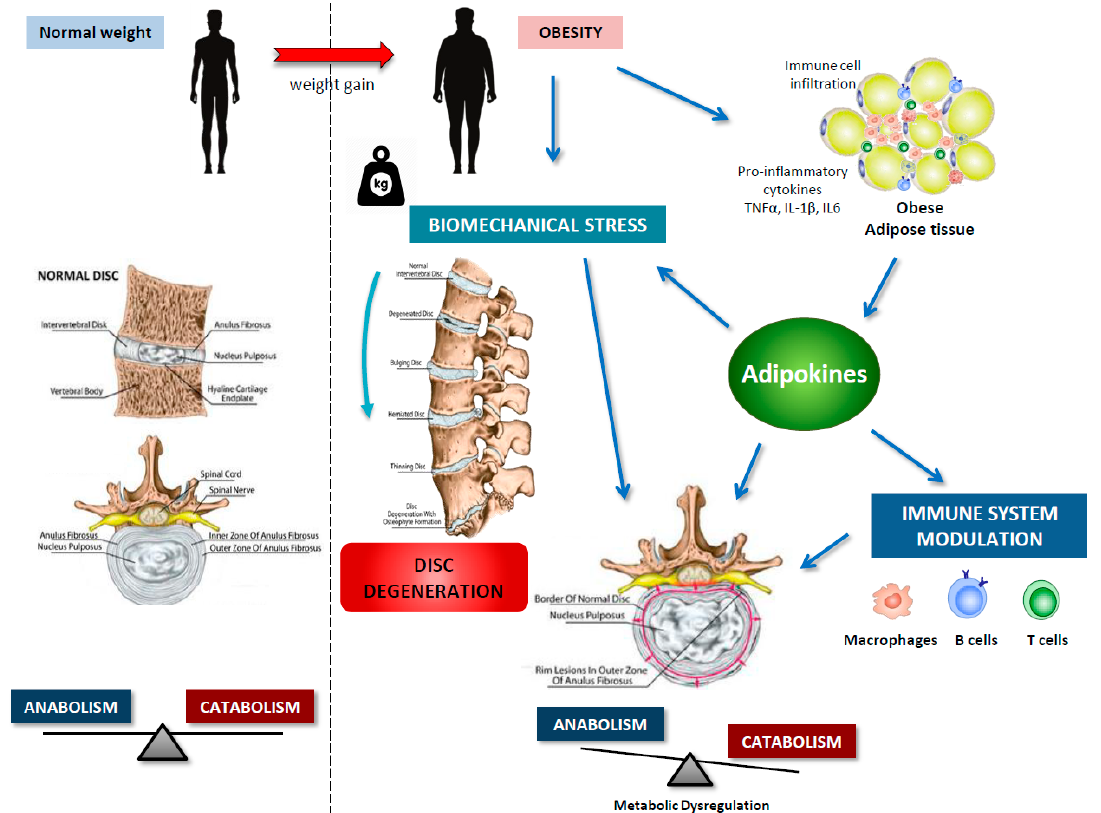
Figure 3. Adipokines as molecular linkers between obesity, immune system and intervertebral disc disease. Body weight gain, accompanied by white adipose tissue expansion, lead to chronic low-grade